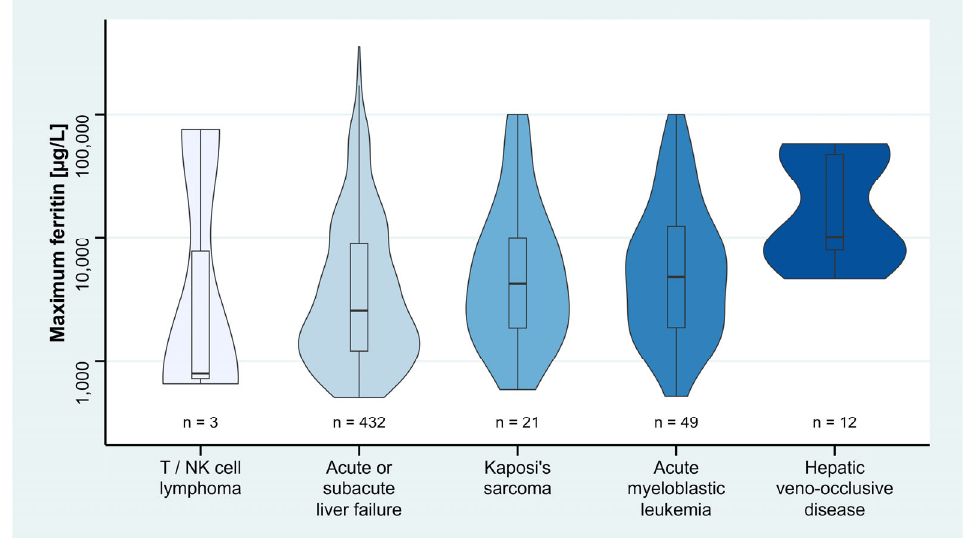
Figure 4 . Ferritin levels of positively associated subgroups of liver disease and hematological malignancy on maximum ferritin. Violin plots show data distribution and enclosed boxplots show median with quartiles (25–75%). Whiskers below and above show minimum and maximum values, respectively. For improved visualization, y ‐ axis is plotted in logarithmic scale. Due to various numbers of ICD ‐ 10 codes in each single patient, patients partially overlap between the groups. NK, natural killer.